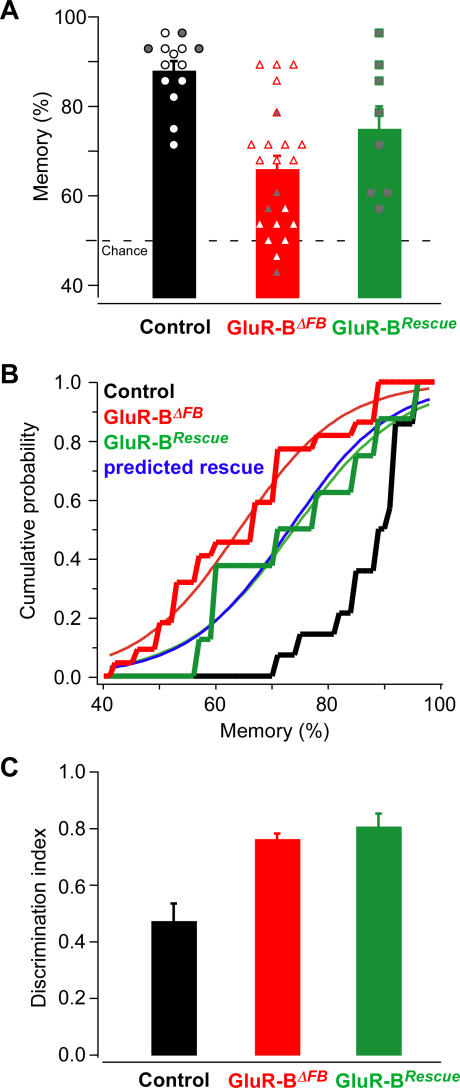
GluR-B Expression in Hippocampus and Forebrain Partially Rescues the Memory Deficit of GluR-BΔFB Mice(A) Olfactory memory experiments as in Figure 2 were performed with GluR-BRescue. Individual mice are indicated: control GluR-B2lox with black circles, GluR-BΔFB with red triangles, GluR-BRescue with green squares. Data were combined from Figure 3 and 4 (open symbols) and an additional experiment with four GluR-BΔFB, three littermate controls, and eight GluR-BRescue (shaded symbols).(B) Cumulative histogram of the memory performance. Memory performance is indicated as a stepped line. The sigmoidal fit is indicated as a continuous line. The predicted rescue on the basis of the extent of transgenic GFPGluR-B expression (Figure 5D) and the correlation between memory and GluR-B levels in piriform cortex (9.1 ± 2.5% increase in memory for 10% increase in protein, Figure 4D) is shown in blue. Note that the predicted rescue is in perfect numerical correspondence to the memory performance of GluR-BRescue mice.(C) The discrimination index was calculated as in Figures 1E, 2C, and 4D (last 100 trials of the mixture discrimination task) for GluRBRescue (n = 8), GluR-BΔFB (n = 22), and control (n = 14) animals.